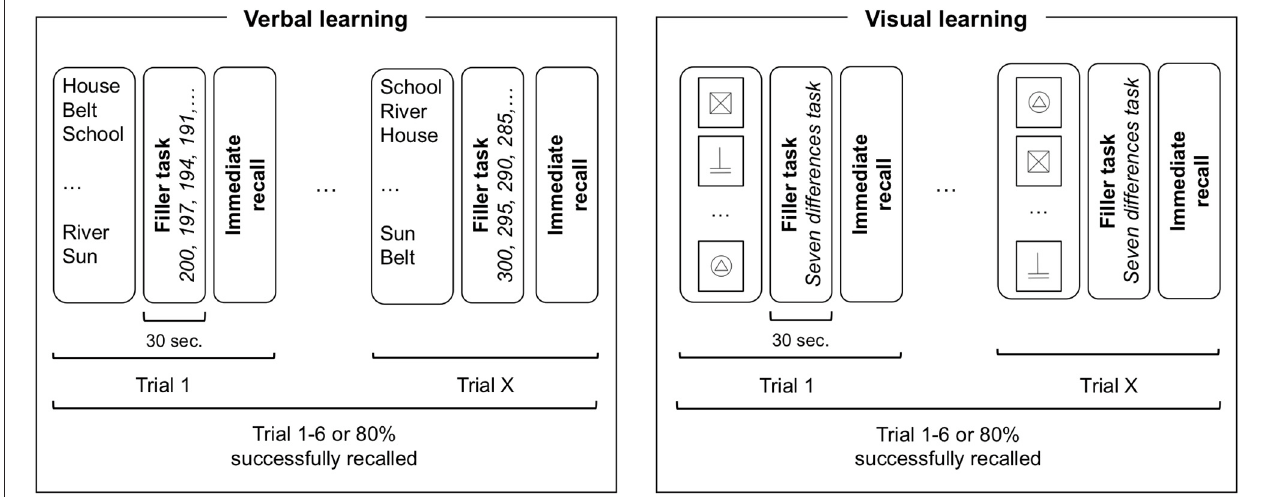
FIGURE 1 | Task design illustration of verbal and visual learning. For each trial, all 15 items are presented in a randomized order followed by a filler task of 30s before immediate recall. The learning phase is finished when the participant either reaches a learning criterion (80% of items successfully recalled) or after six consecutive trials. Participants performed either verbal or non-verbal task first in a counterbalanced order.